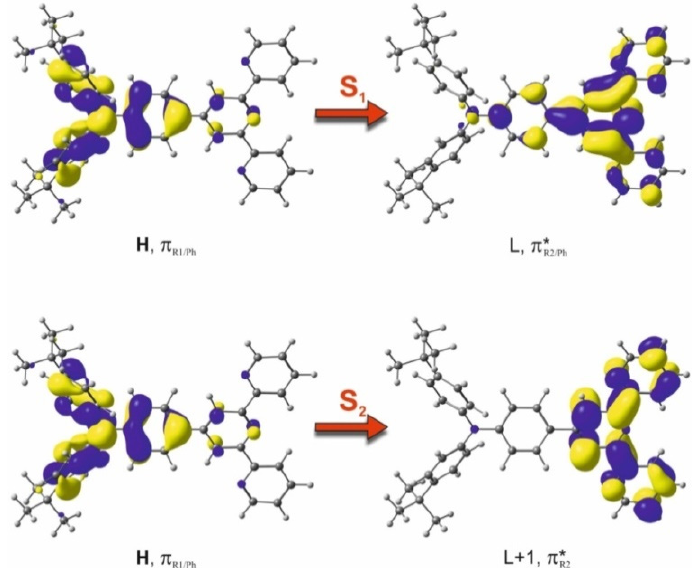
Figure 9. Kohn—Sham orbitals involved in the two lowest electronic transitions from the S 0 to the S 1 and S 2 states. Both excitations have π → π *characters and are of CT type. H, L, and L+1 are used as abbreviations for HOMO, LUMO and LUMO+1, respectively.